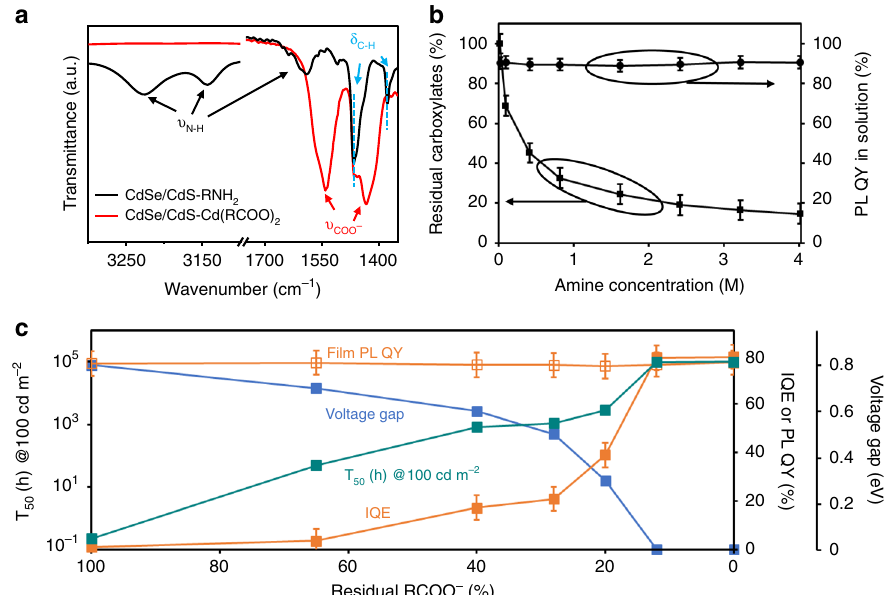
Fig. 3 Cadmium-carboxylate concentration-dependent PL and EL properties of the CdSe/CdS QDs. a FTIR spectra of the as-synthesized CdSe/CdS-Cd (RCOO) 2 QDs (red) and the completely surface-treated CdSe/CdS-RNH 2 QDs (black). Vibration bands of RNH 2 and Cd(RCOO) 2 are labeled as ν N-H and ν COO -, respectively. b Residual carboxylate percentages and PL QY of the CdSe/CdS core/shell QDs in solution vs. different concentration of primary amine used in the ligand-exchange procedures. c PL QY of the QD fi lms, IQE of the QLEDs, operational lifetime of the QLEDs, and voltage gap of the QLEDs vs. the residual percentage of carboxylate ligands identi fi ed by